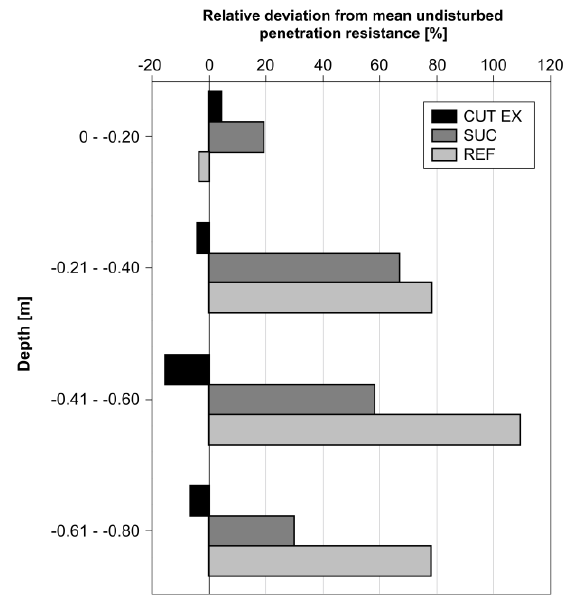
Figure 17. Relative penetration resistance deviation of backfilled areas compared to undisturbed soil; depth-aggregated data. Table 17. Kruskal–Wallis test for simplified areas (Undisturbed, CUT EX, SUC, REF). Significantly di ff erent areas ( p < 0.05) are indicated bold.